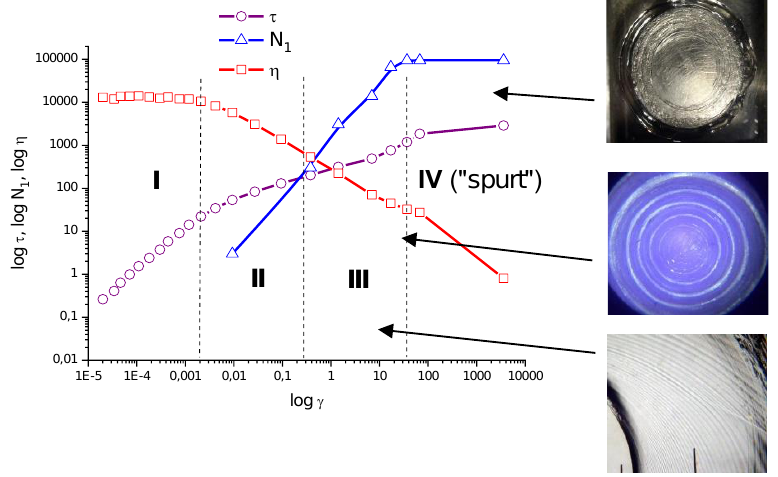
Figure 17. Rheological characteristics and morphology of stream for PIB solution filled with clay particles. Designation of zones: I — Newtonian flow, II — viscosity anomaly, III — area of dominant elasticity, IV — spurt behavior. Morphology of the sample is shown for zones III ( bottom photo) and IV ( top photo). 1E-5 — 1 × 10 − 5 ; 1E-4 — 1 × 10 − 4 .